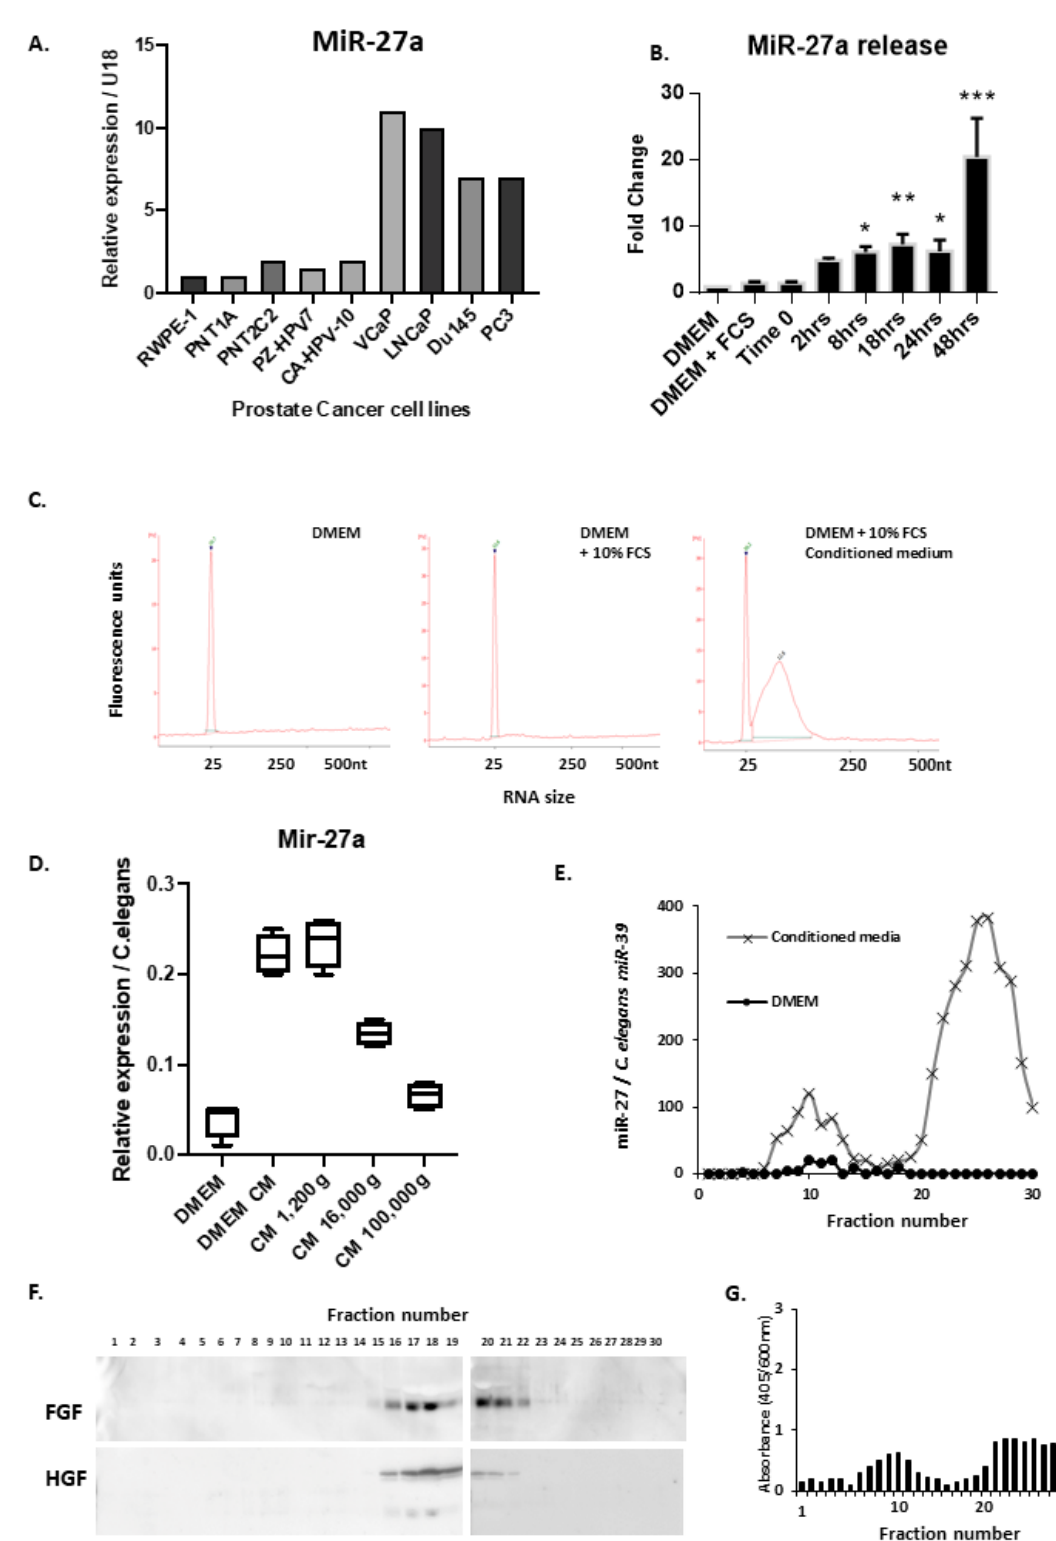
Figure 3. Prostate Cancer cells secrete large quantities of miRNAs both as Extracellular vesicles and as free or protein-bound miRs. ( A ), Q-PCR analysis of miRNA-27a expression from a panel of prostate cancer or normal prostate derived immortalised cell lines. Data is normalised to U18 small nuclear RNA and plotted relative to the RWPE-1 cell line. ( B ), Q- PCR analysis of miR-27a release into conditioned media form PC3 cells over 48 h. Data is normalised to U18 small nuclear RNA. ( C ), RNA extraction and bioanalysis of RNA from media (DMEM), media with FCS and conditioned media from